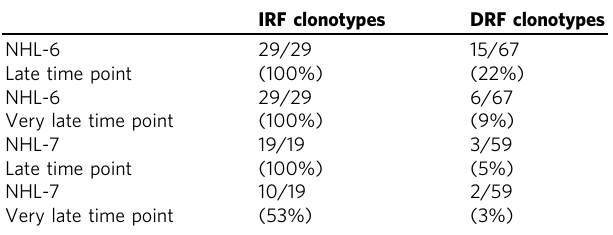
in a larger cohort of patients are required to determine the exhaustion state of CAR-T cells after infusion and whether the single-cell transcriptional pro fi le of CAR-T cells in the blood are representative of CAR-T cells in the tumor.